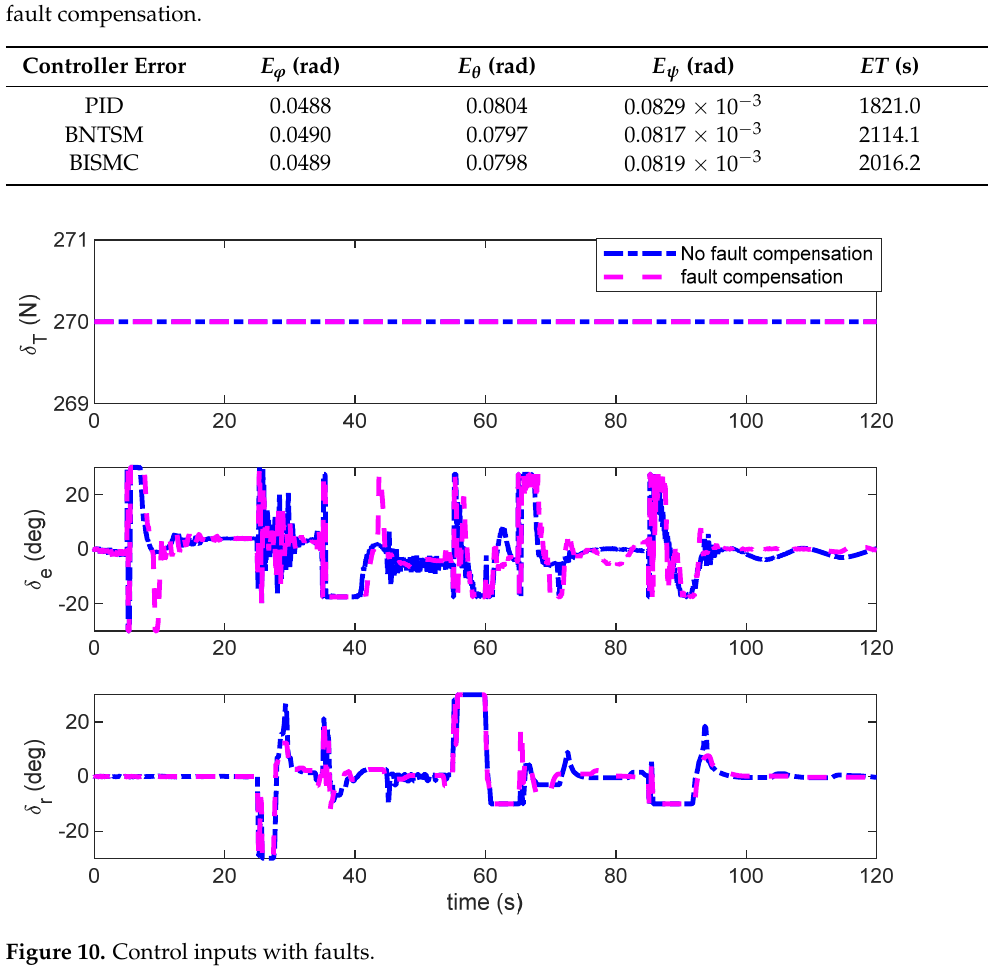
Tracking errors and ET of the airship under the input of the controller with